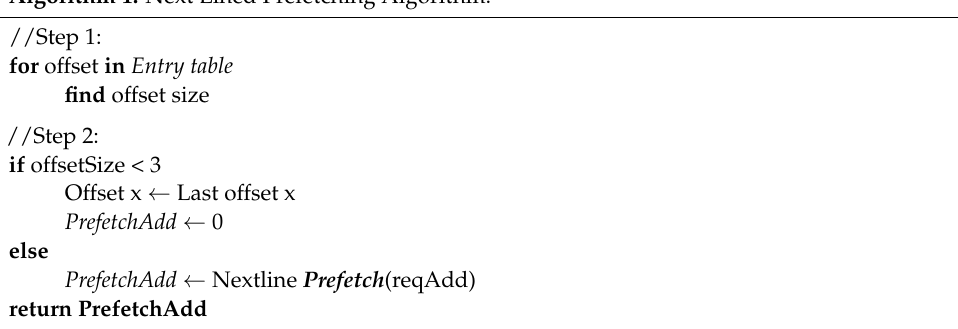
Algorithm 1: Next Lined Prefetching